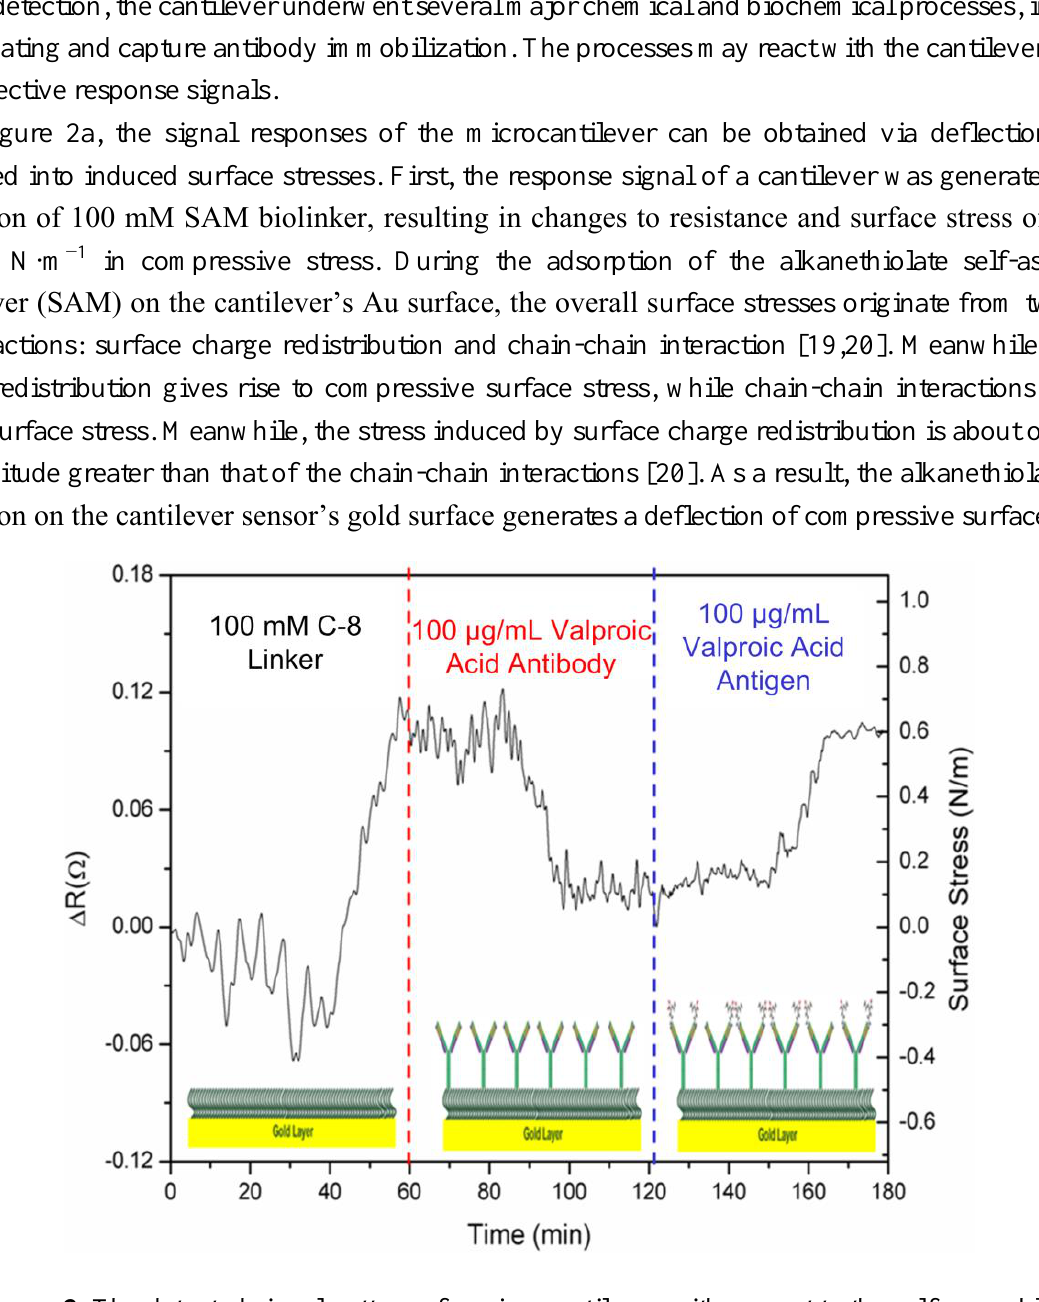
Figure 2. The detected signal pattern of a microcantilever with respect to the self-assembled monolayer coating, capture antibody immobilization and the antiepileptic drug,valproic